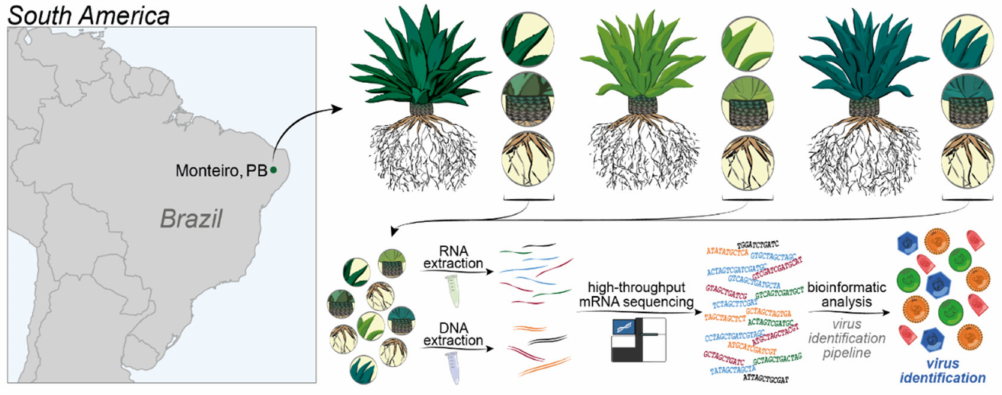
Figure 1. Strategy applied to uncover the virome of Agave species. The dot in the map indicates the localization of Monteiro, in the state of Para í ba. Agave fourcroydes , Agave sisalana and Agave Hybrid 11648 (and their respective organ samples) are indicated in different tones of green, for differentiation purposes. The following methods are indicated in the lower portion of the figure; RNA extraction, DNA extraction, high-throughput sequencing in the Illumina platform, and bioinformatics analysis (see further details in the Material and Methods